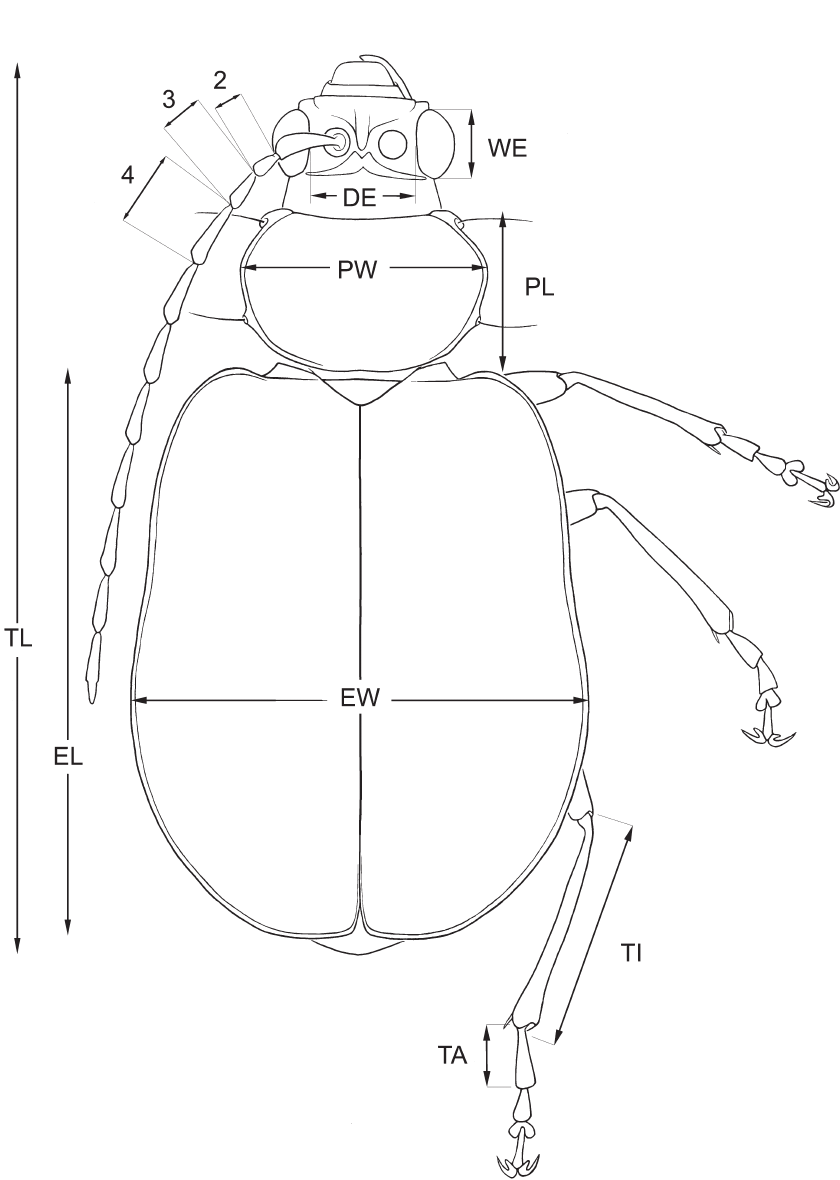
Fig. 1. Measurements taken. Absolute measurements: TL = total length from apex of labrum to apex of elytron; PL = pronotal length; PW = maximum pronotal width; EL = elytral length; EW = maximum width of elytra combined. Relative measurements: 2, 3, 4 = length of second, third and fourth antennomeres; DE = minimum distance between eyes; WE = maximum width of eye; TA = length of basimetatarsus; TI = length of